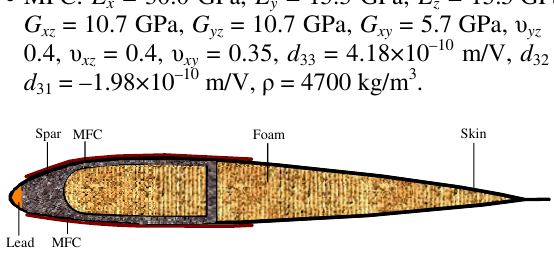
Fig 1. Cross-section of the helicopter rotor blade